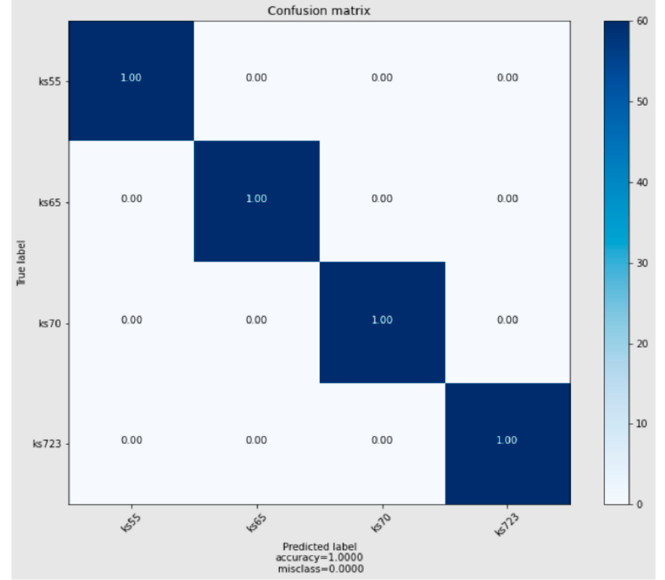
Figure 7. Confusion matrices obtained under the optimal model for the test sets of four ores. It can